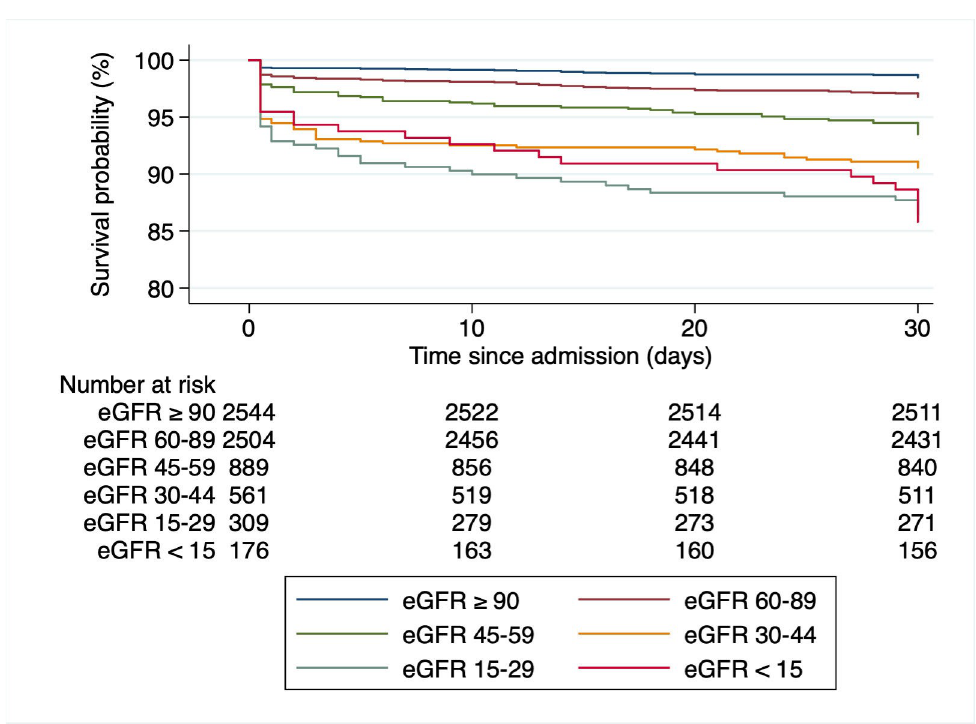
Fig 2. Kaplan-Meier survival estimates by eGFR groups. x-axis, day since admission, y-axis, Proportion of patients alive, eGFR, estimated glomerular filtration rate (ml/min/1.73m 2 ).